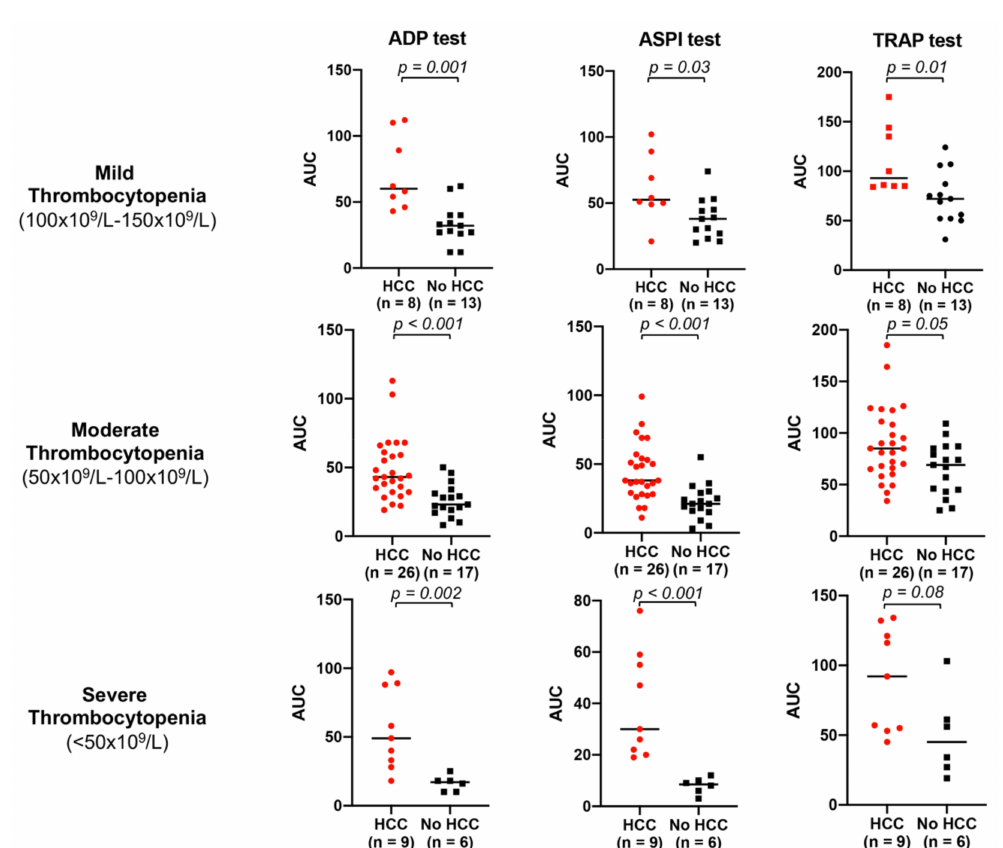
Figure 3. Platelet aggregation is significantly increased in cirrhosis patients with vs. without HCC in all 3 classes of thrombocytopenia. Legend: HCC: hepatocellular carcinoma; ADP: adenosine diphosphate; ASPI: arachidonic acid pathway test; TRAP: thrombin receptor agonist peptide. Red circles: patients with cirrhosis with HCC. Black squares: patients with cirrhosis without HCC. For numerical values, see Supplementary Table